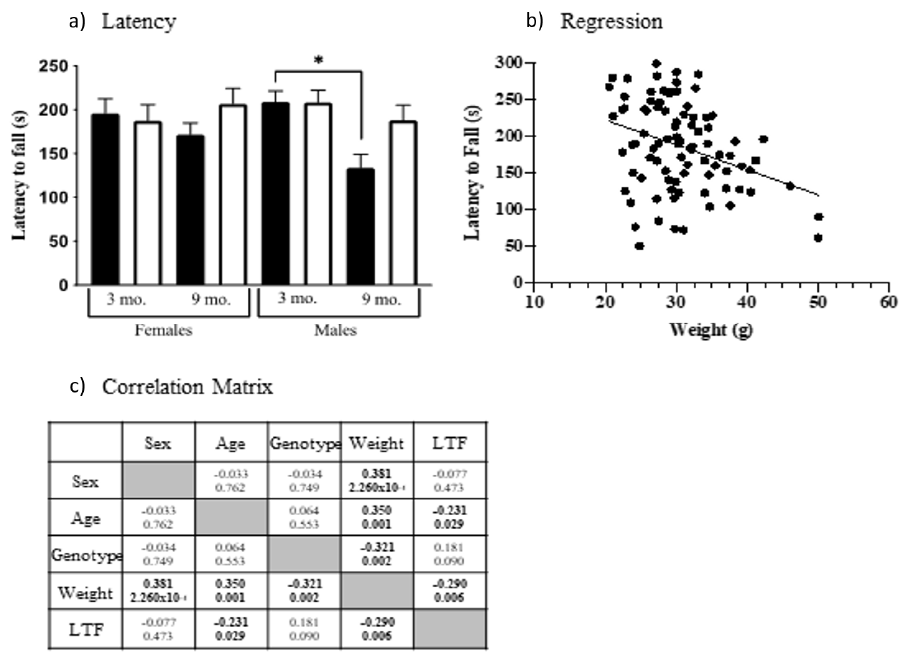
Figure 3. Rotarod performance. ( a ) Latency to fall. Black bars, controls; white bars, Dp10. Significant differences are indicated with *. ( b ) Regression, mouse weights vs. latency to fall. ( c ) Spearman correlation, r -values, and p -values; significant correlations are shown in bold.